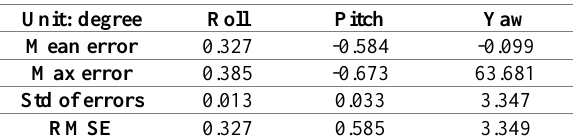
Table 7 .Accuracy of angles during conducing initial alignment with data after processing and parameters of the IMU error model from Allan variance test Table 8 shows the errors of three attitudes after finishing initial alignment. With the initial alignment method proposed in this research, the initial attitudes can achieve smaller than 1 degree accuracy.